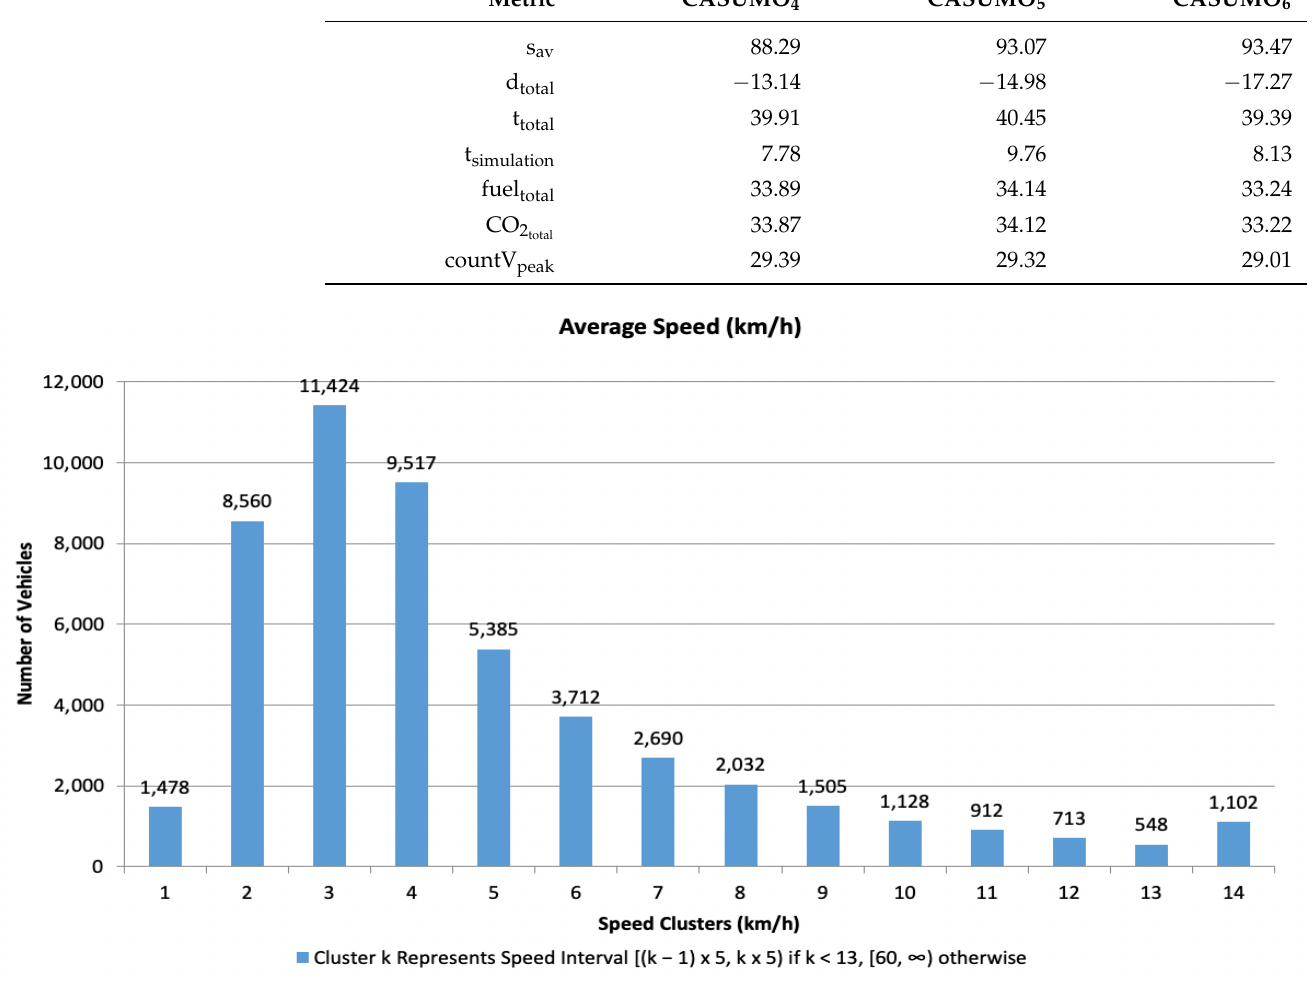
Figure 6. Speed distribution in clusters for 50 K+ simulated vehicles in New York with δ = 5.